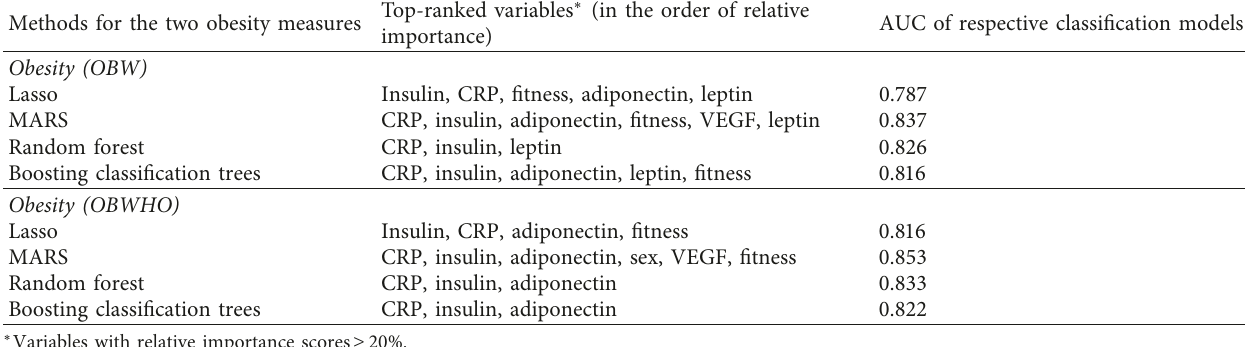
∗ Variables with relative importance scores ≥ 20%.